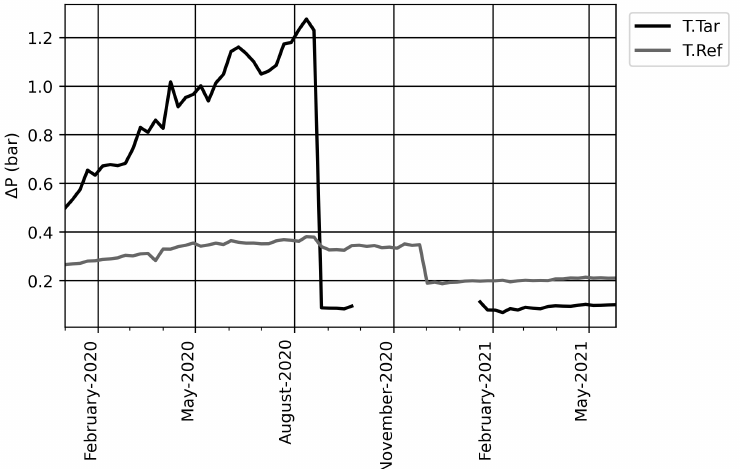
Figure 5. Evolution of oil filter pressure (in September 2020 the faulted turbine was stopped up to January 2021).